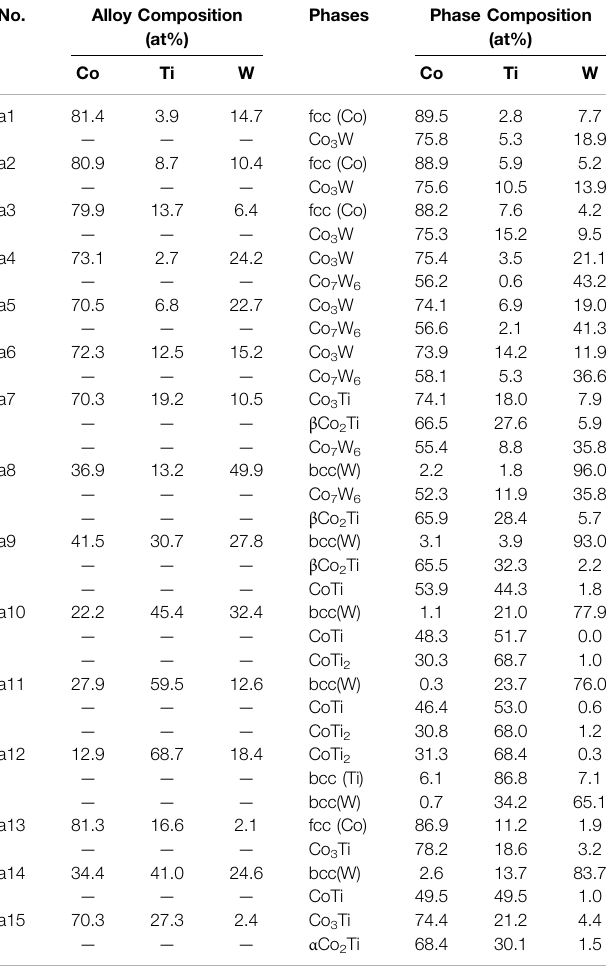
TABLE 2 | The constituent phases and their compositions of the Co – Ti – W alloys annealed at 1273 K. No.